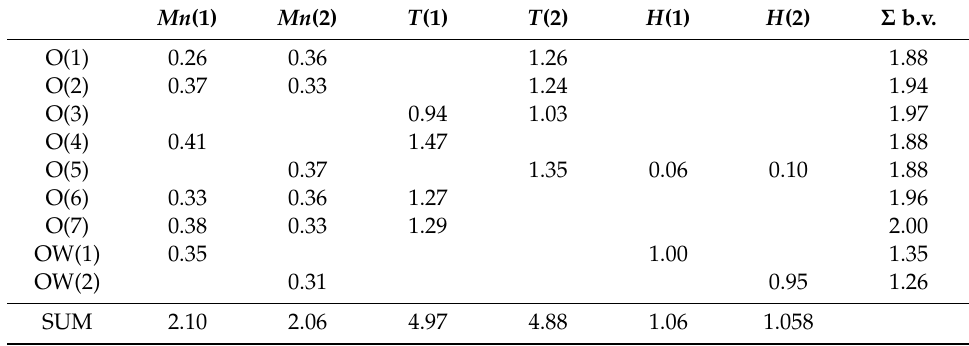
Table 6. Bond Valences (in Valence Units) for Rüdlingerite (Fianel Specimen) using [29]. Mn (1) Mn (2) T